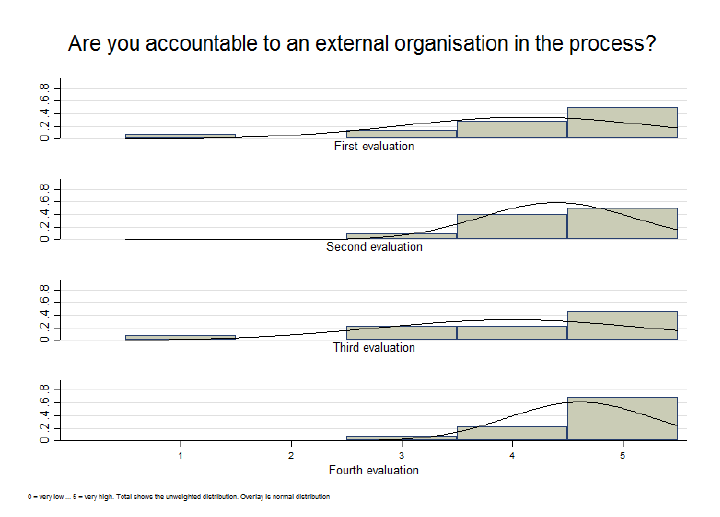
Figure A1.3 Results from the TANK process over time, “I understand the extent to which I am accountable to an